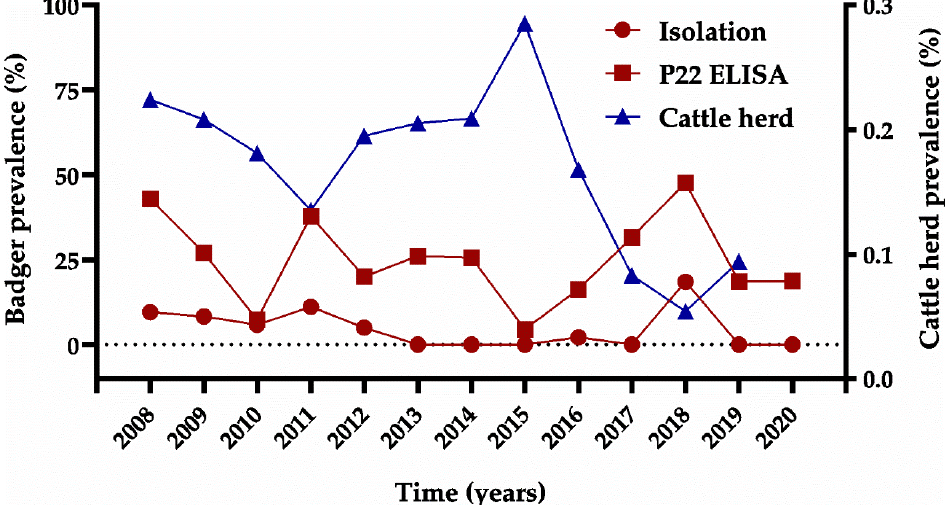
Figure 2. Prevalence of tuberculosis (TB) among badgers (red lines) and cattle (blue line) by year (2008–2020). Red circles refer to results based on bacterial isolation; red squares refer to results based on the P22 ELISA. TB prevalence based on single intradermal tuberculin test data and bacterial isolation was available for cattle herds as part of the Spanish National Program for the Eradication of Bovine TB [2].